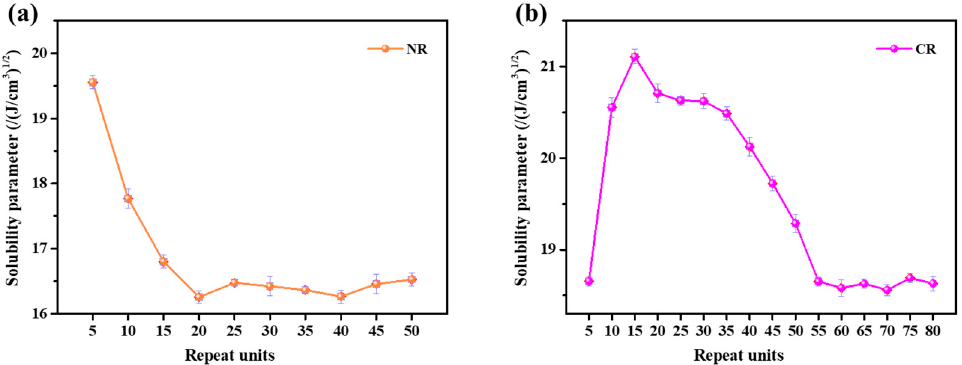
Figure 3. Relationship between repeat units and solubility parameter of ( a ) NR and ( b ) CR. Table 4. Parameters after geometric optimization of the NR/CR blending models.